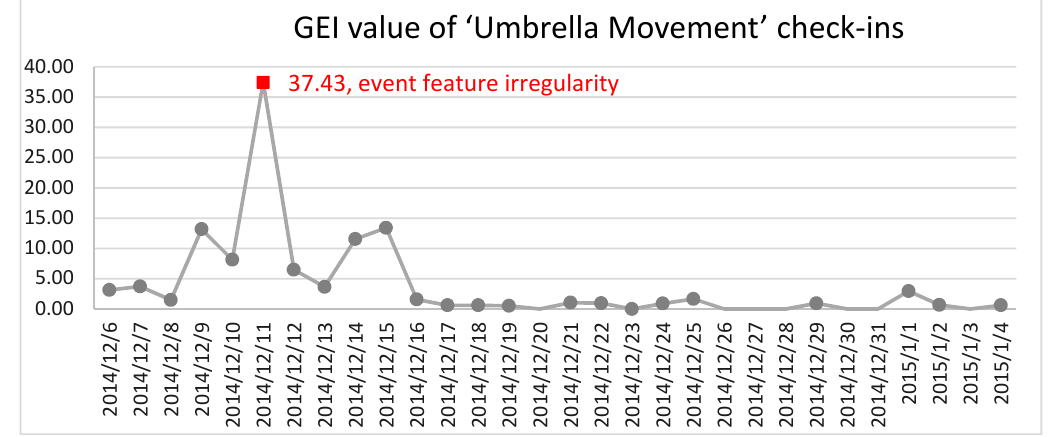
Figure 5. Detected feature irregularity as the ’Umbrella Movement’ event on 11 December 2014.